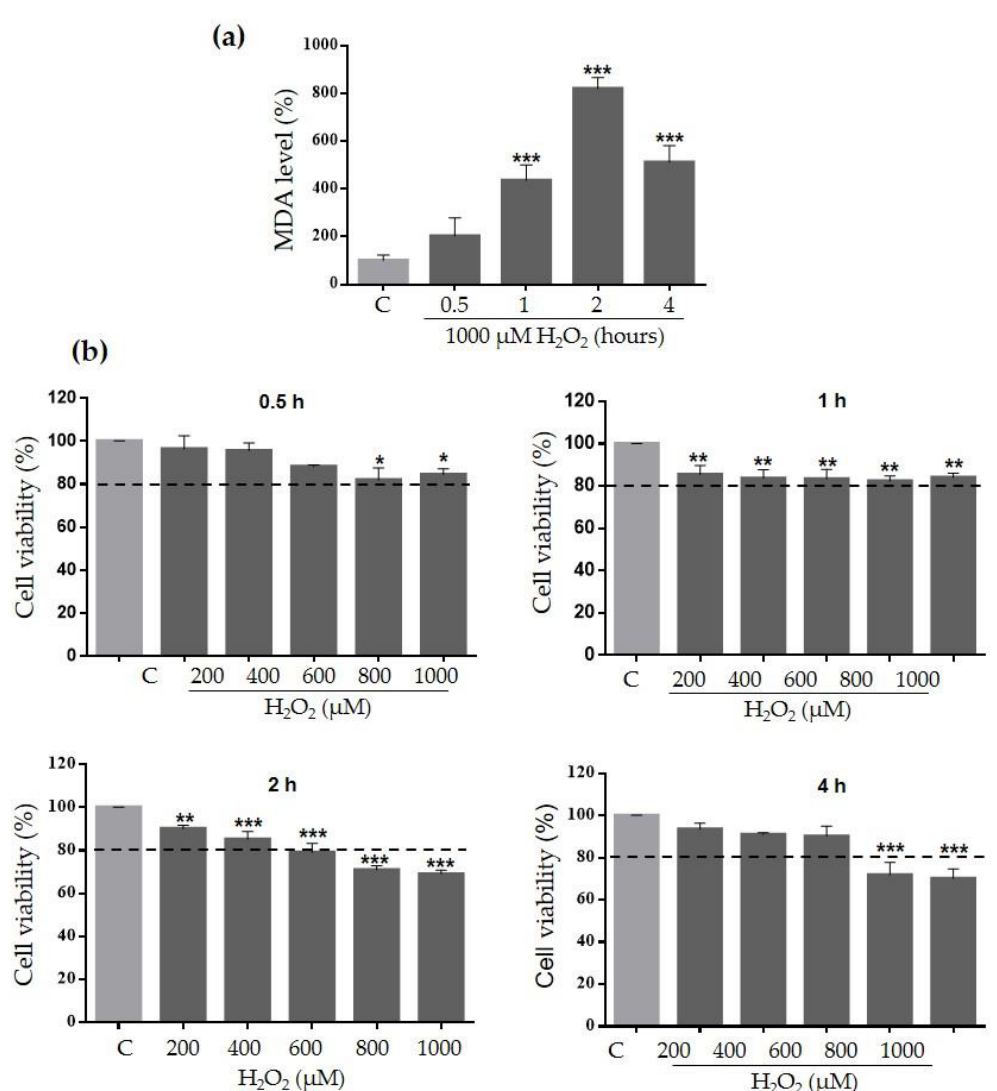
Figure 2. Establishment of H 2 O 2 -induced oxidative damage and cytotoxicity model on HaCaT cells. ( a ) Quantification of MDA levels to the determination of H 2 O 2 -induced lipoperoxidation. HaCaT cells were treated with 1000 µ M H 2 O 2 for 0.5, 1, 2, or 4 h. ( b ) MTT assay to the determination of H 2 O 2 -induced cytotoxicity. HaCaT cells were treated with H 2 O 2 (200–1000 µ M) for 0.5, 1, 2, or 4 h. Results were expressed as the mean ± SD of three independent experiments. One-way ANOVA, Dunnett’s test: * p < 0.05, ** p < 0.01, *** p < 0.001 versus